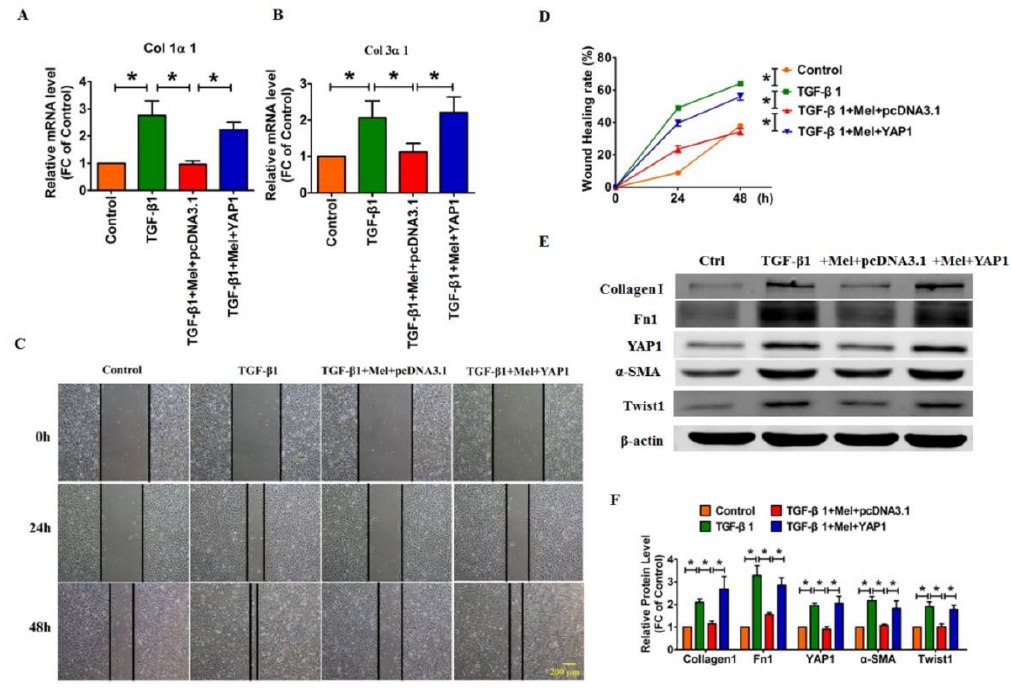
Figure 5. Forced expression of YAP1 abrogated the inhibitory effect of melatonin on production of collagen. ( A , B ) Real-time RT-PCR analysis showing that YAP1 overexpression blunted the inhibitory effects of melatonin on TGF- β 1-induced up-regulation of Col 1 α 1 and Col 3 α 1 at the mRNA level. n = 6 cell batches. Representative photomicrographs showing that YAP1 restored the cell migration ability ( C , D ) compared with the TGF- β 1+melatonin group. ( E , F ) Western blotting was used to determine the effect of YAP1 overexpression on the inhibitory effects of melatonin in TGF- β 1-induced up-regulation of pro-fibrotic proteins, including collagen 1, Fn1, α -SMA and Twist1.Values are the mean ± SEM of five independent experiments. * p <